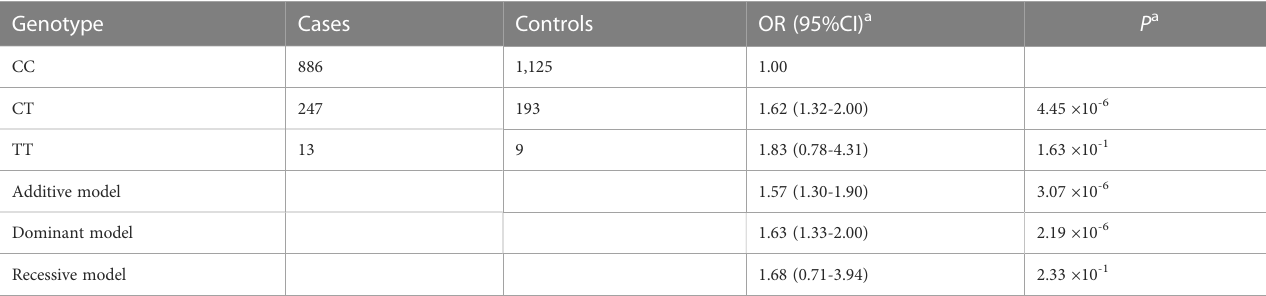
TABLE 1 Association analysis between PDE1C rs12538364 and colorectal cancer risk in the Chinese population. Genotype